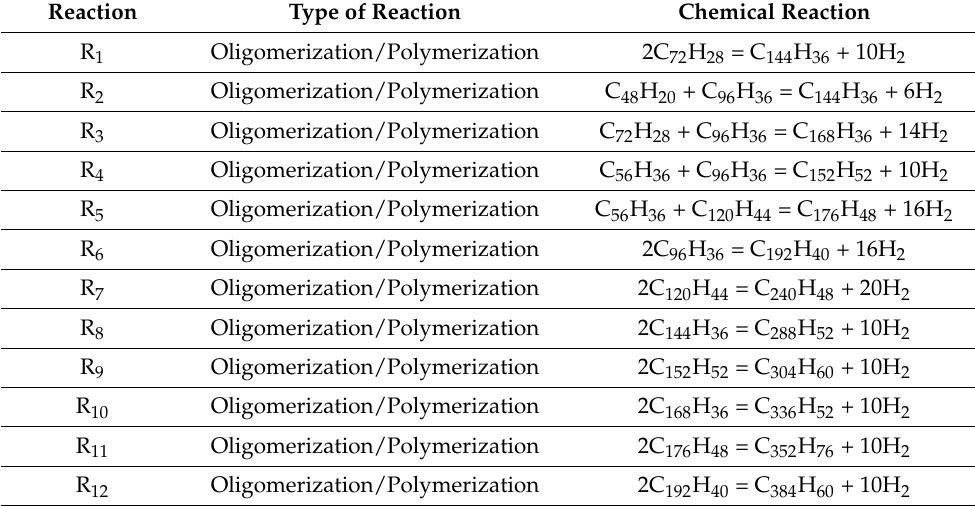
Table 3. Proposed prototype polymerization reactions in semi-coke/coke formation step of carboniza- tion